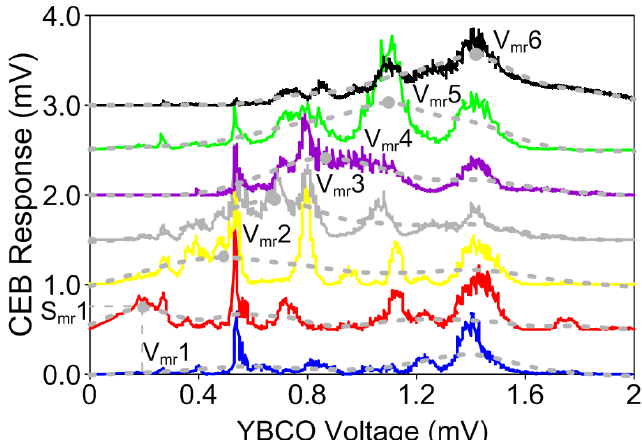
Figure 6. CEBs response for increasing magnetic fields through the YBCO oscillator. For convenience, the curves starting from the second one are shifted up by 0.5 mV relative to the previous one. Marks correspond to the local maximum of each smoothed